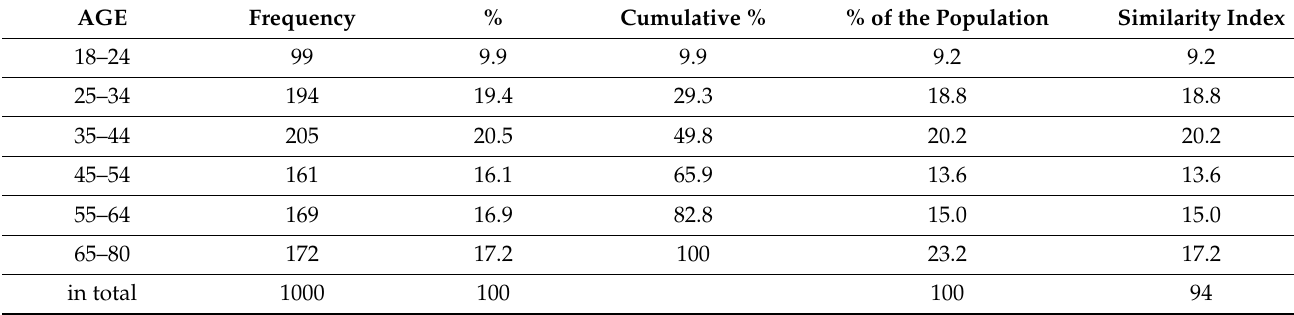
Table 2. Age of the respondents.